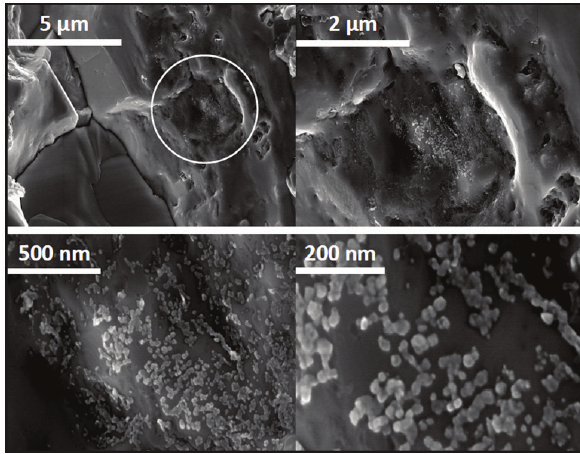
Figure 2. Confirmation of nano-sized secondary phases migrating along the grain boundaries.